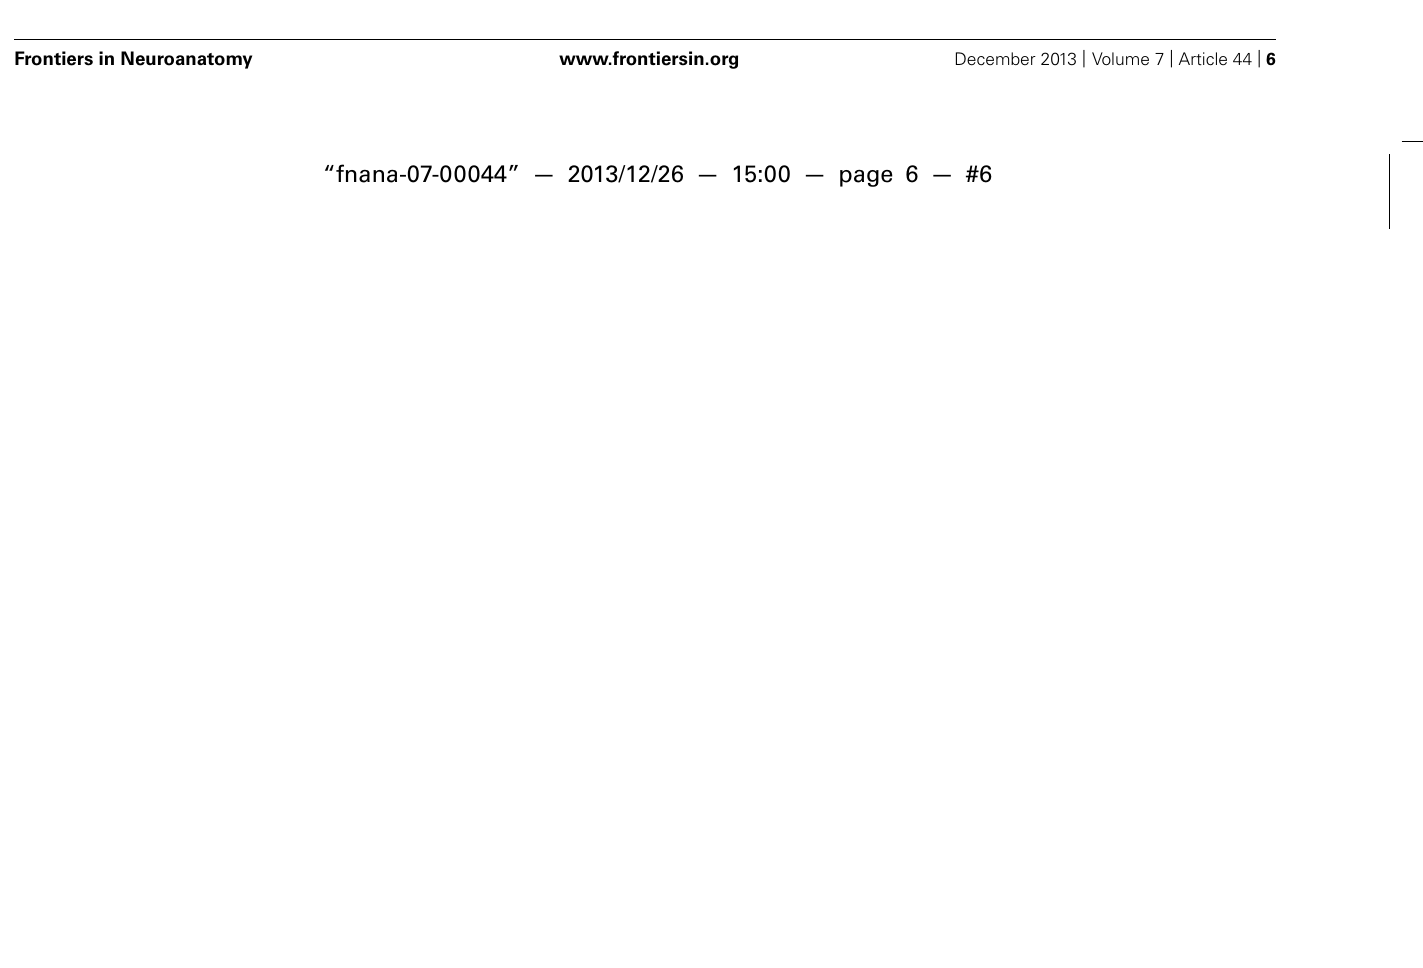
FIGURE 2 |The MRIT 2 W scanning showed clear hyperintensity lesion site appear in brain cortex of vehicle treated EAE rats but not in CNTF and C16 treated EAE rats. (A) Vehicle treated EAE rats at week 2 post-immunization, arrow illustrating a clear hyperintensity area in the white matter.There were no visible lesion foci in (B) CNTF treated EAE rats, (C) C16 treated EAE rats, and (D) C16 + CNTF treated EAE rats at week 2